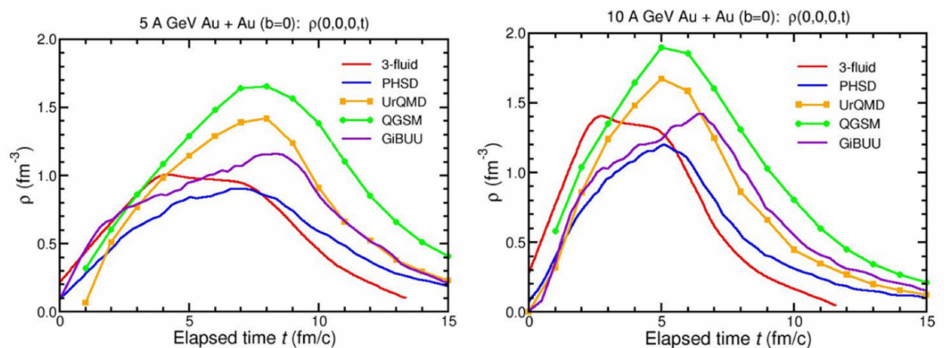
Figure 1. Central net baryon density ρ (t) versus time calculated by various microscopic transport models and by a 3 fluid hydrodynamics code for central Au + Au collision at 5A GeV ( left ) and at 10A GeV ( right )